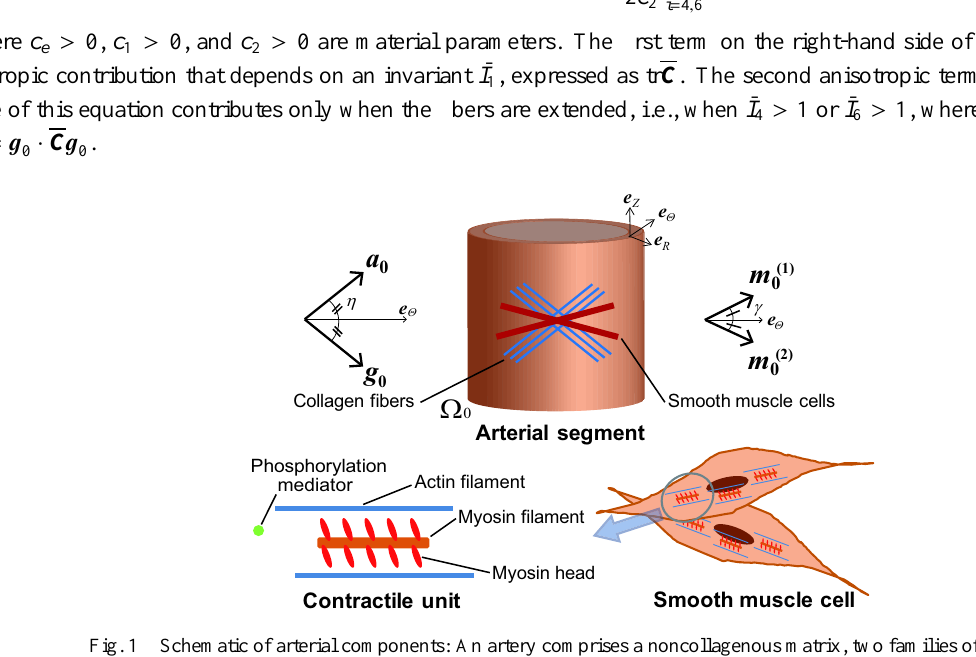
and the unit vectors 0